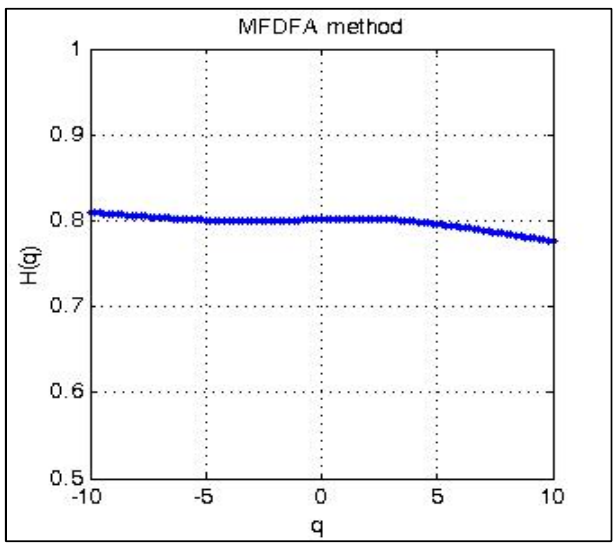
Figure 4. MFDFA method for determining the generalized Hurst exponent .